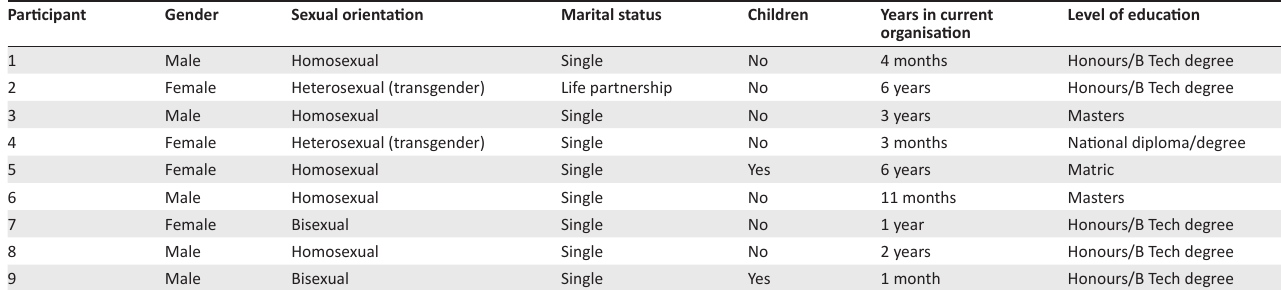
TABLE 1: Demographic profile of